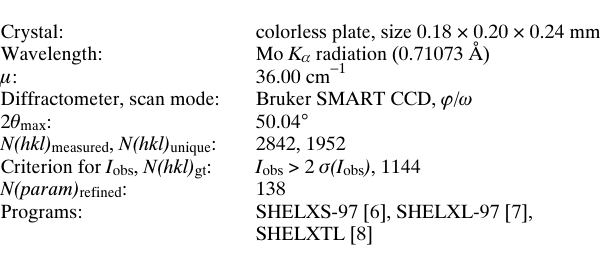
Table 1. Datacollection and handling.